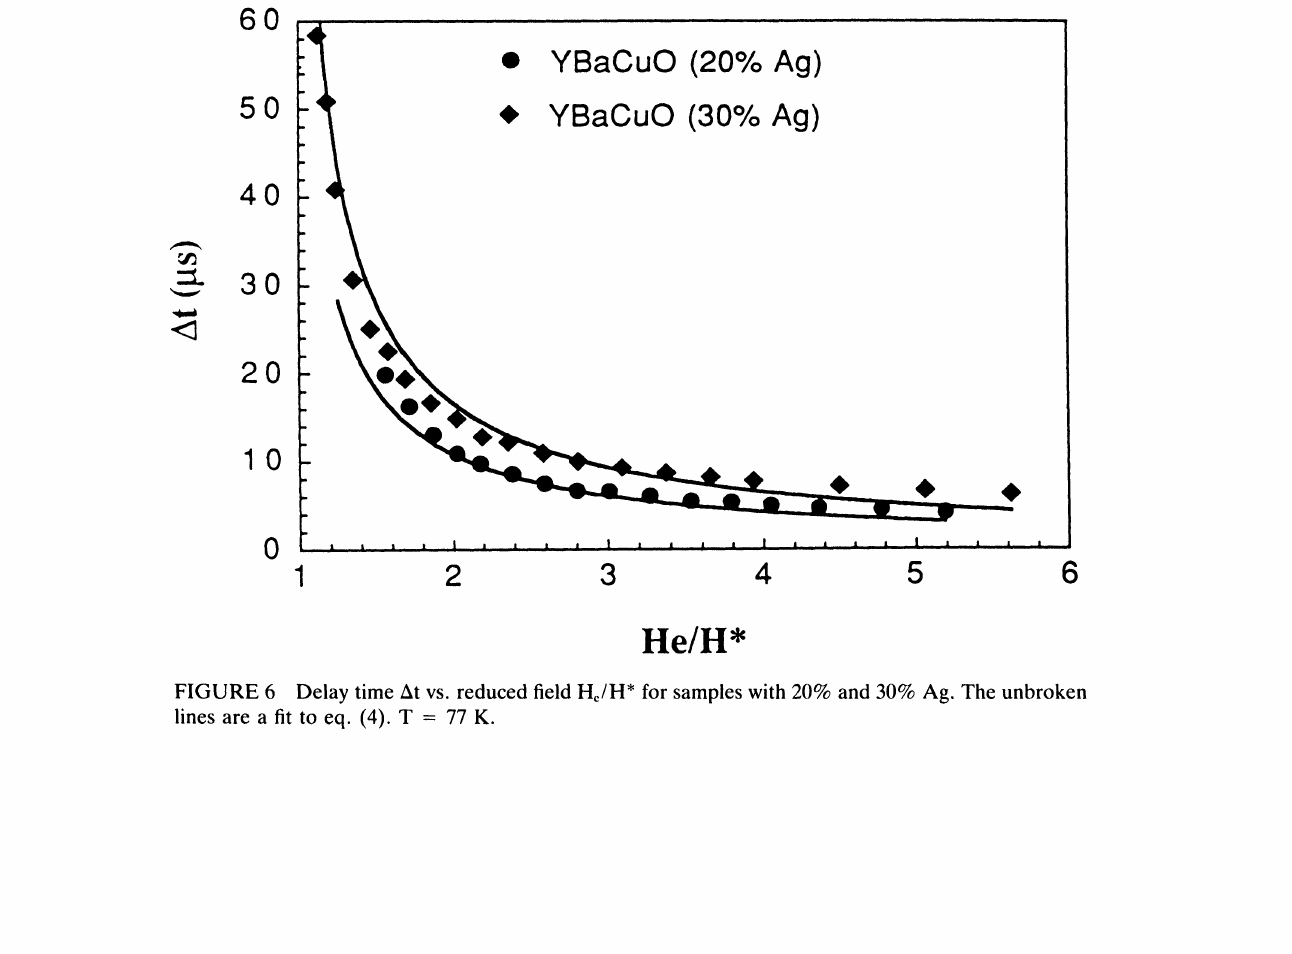
FIGURE 5 Induction in the hole B vs. external field He for samples with 30% Ag and 50% Ag. For each measured point, the sample is cooled from T > Tc to T 77 K. He is then pulsed from zero to the graph’s value.